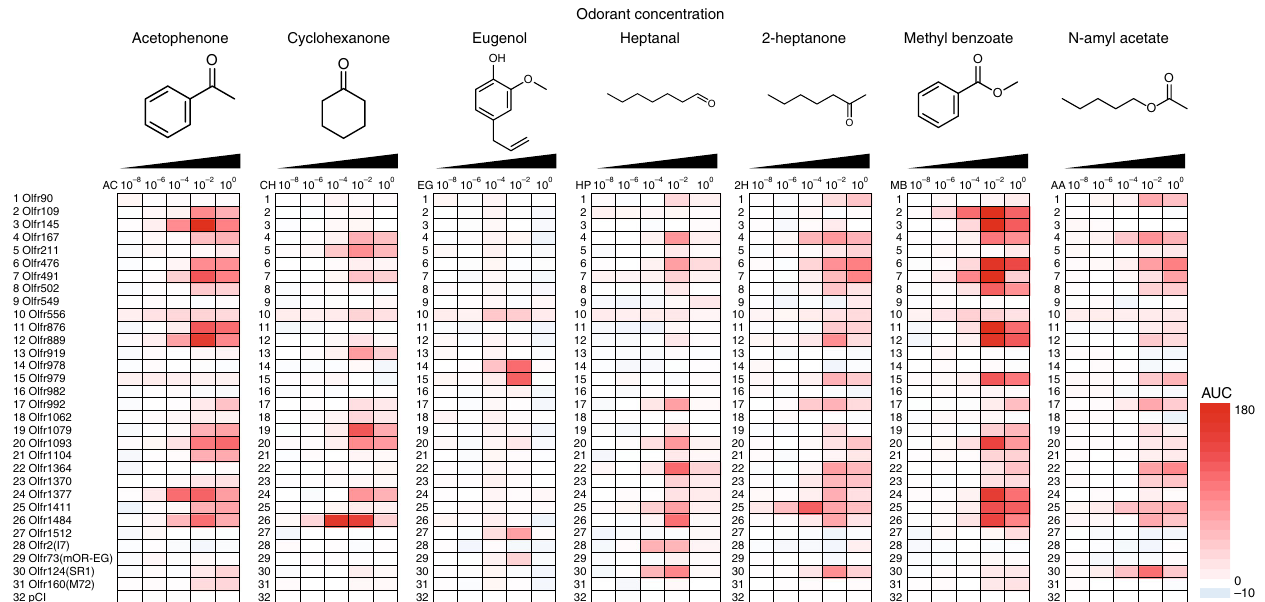
Fig. 5 Heat map of AUC. The number on the left side indicate each OR as follows: 1; Olfr90, 2; Olfr109, 3; Olfr145, 4; Olfr167, 5; Olfr167, 6; Olfr211, 7; Olfr476, 8; Olfr491, 9; Olfr502, 10; Olfr549, 11; Olfr556, 12; Olfr876, 13; Olfr889, 14; Olfr978, 15; Olfr979, 16; Olfr982, 17; Olfr992, 18; Olfr1062, 19; Olfr1079, 20; Olfr1093, 21; Olfr1104, 22; Olfr1364, 23; Olfr1370, 24; Olfr1377, 25; Olfr1411, 26; Olfr1484, 27; Olfr1512, 28; Olfr2(I7), 29; Olfr73(mOR-EG), 30; Olfr124(SR1), 31; Olfr160(M72), 32; pCI (Vector capability to detect and discriminate structurally related odorants